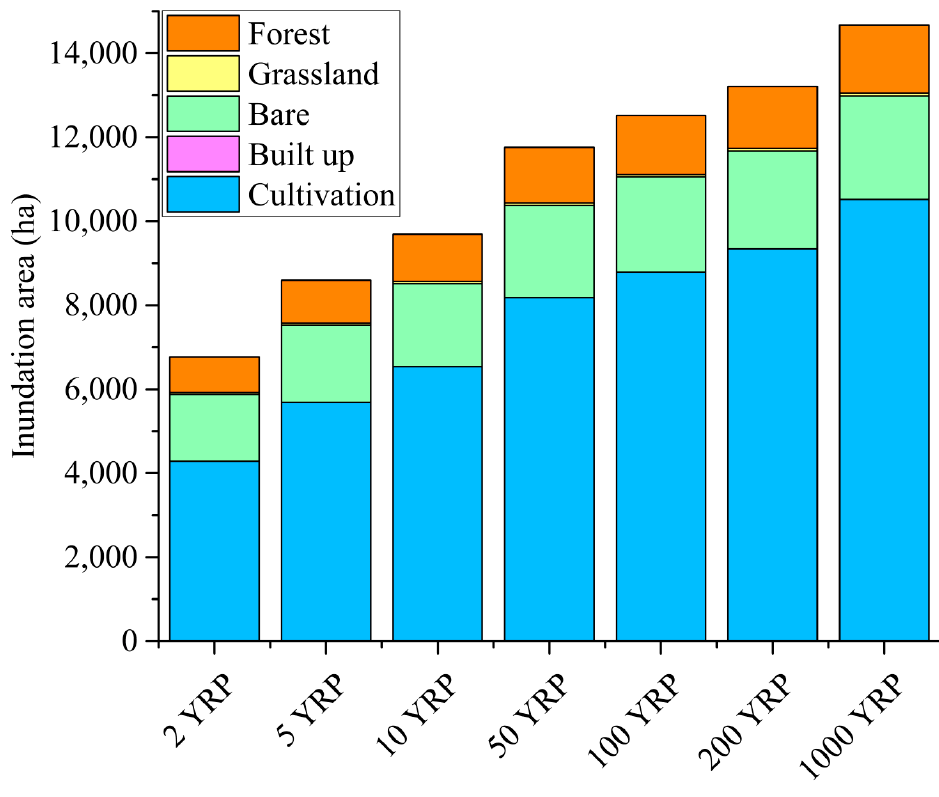
Figure 12. Impacts of different YRP floods on various land cover types in the downstream region (unit: hectares).